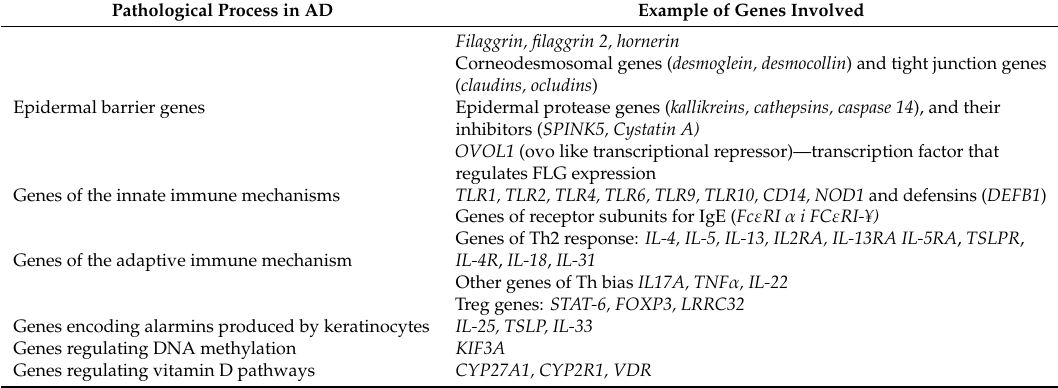
Table 1. Main groups of genes associated with atopic dermatitis (AD) pathogenesis [5–7,9,10,12,23–32]. Pathological Process in